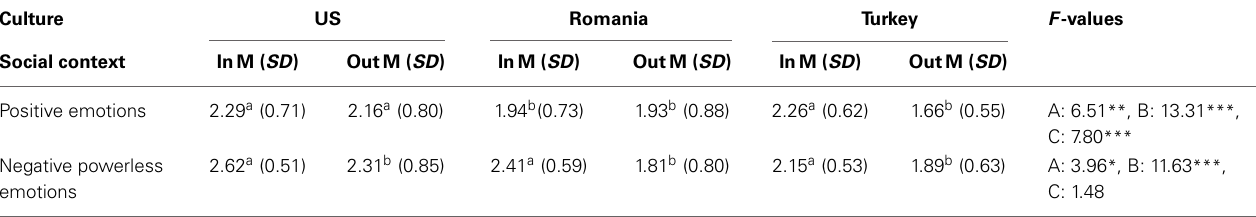
Table 2 | Effects of cultural group and social context on emotion expression intensity.